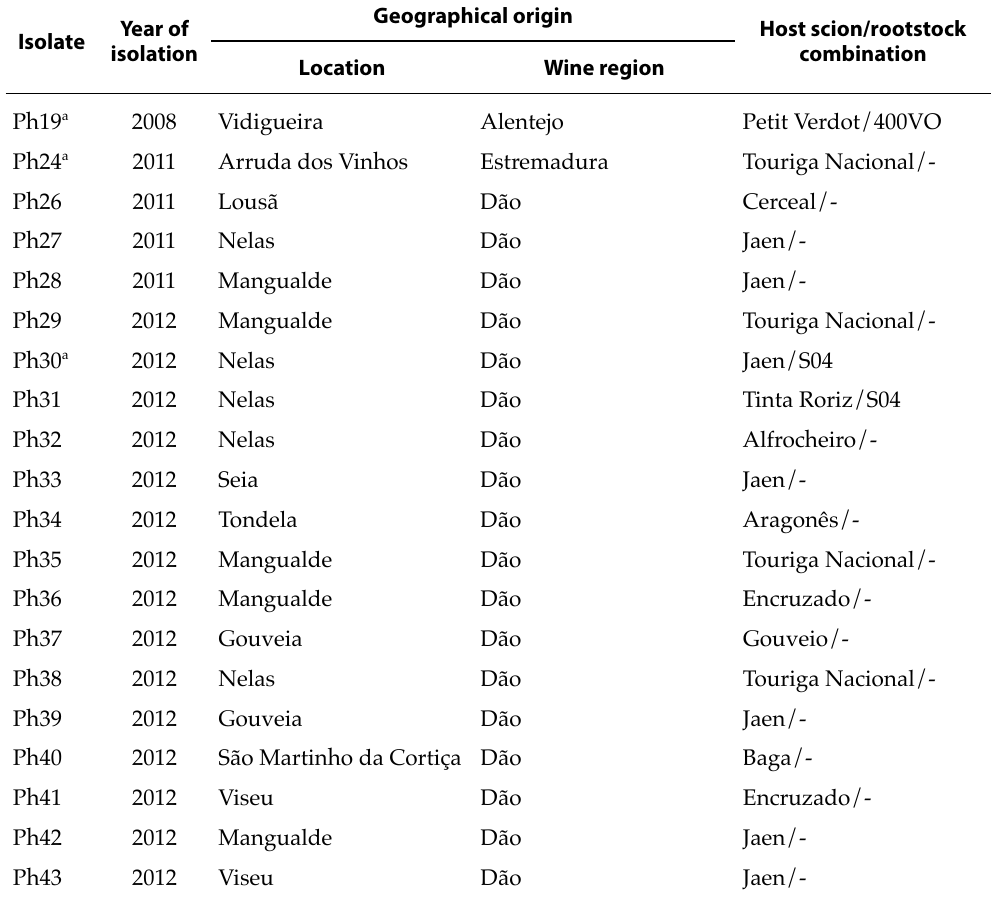
Host scion/rootstock combination